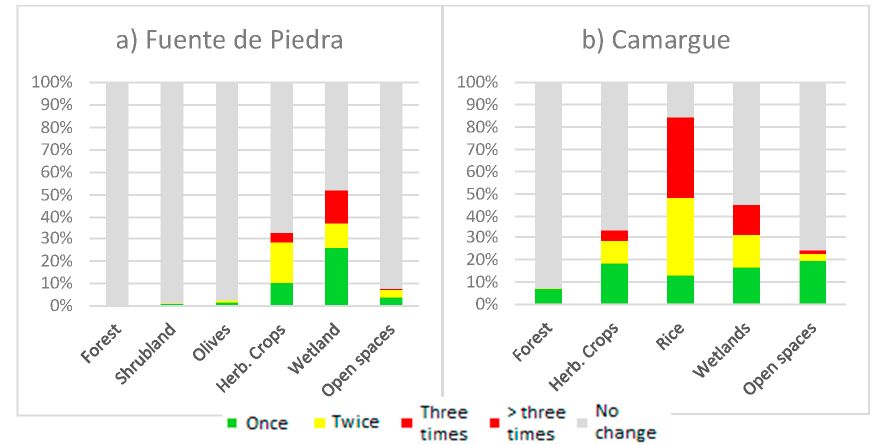
Figure 4. Frequencies of change aggregated in LULC classes in Fuente de Piedra ( a ) and Camargue ( b ). Each chart accounts for the proportion of pixels of each LULC class where a change was detected once, twice, three or four or more times. The gray portion of the bar corresponds to areas where no change was detected.